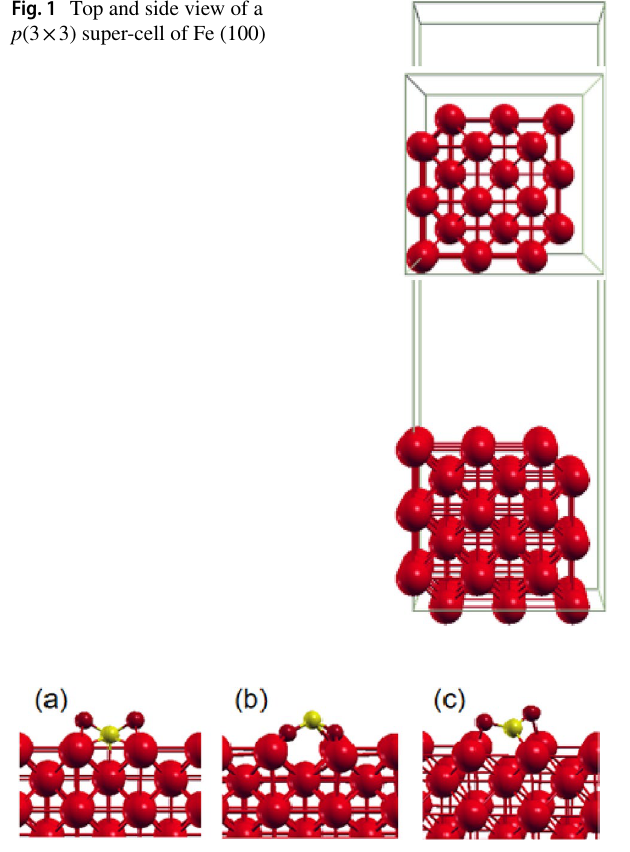
Fig. 2 Optimized structures of CO flip-C